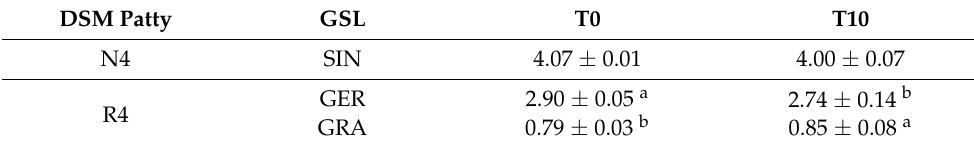
Table 2. GSL content of DSM patties N4 and R4 at the beginning (T0), and the end of the trial (T10), after 10 days of storage at 33 ◦ C. Mean values ± standard deviation ( n = 3) are shown. GSL is expressed as ¦ µ mol/g of patty ( ± SD). Statistical differences between GSL content means are indicated by different superscript letters ( p < 0.05, LSD test). SIN indicate the sinigrin content in N4, GER, and GRA indicate the glucoerucin and the glucoraphanin respectively content in R4. DSM Patty GSL T0